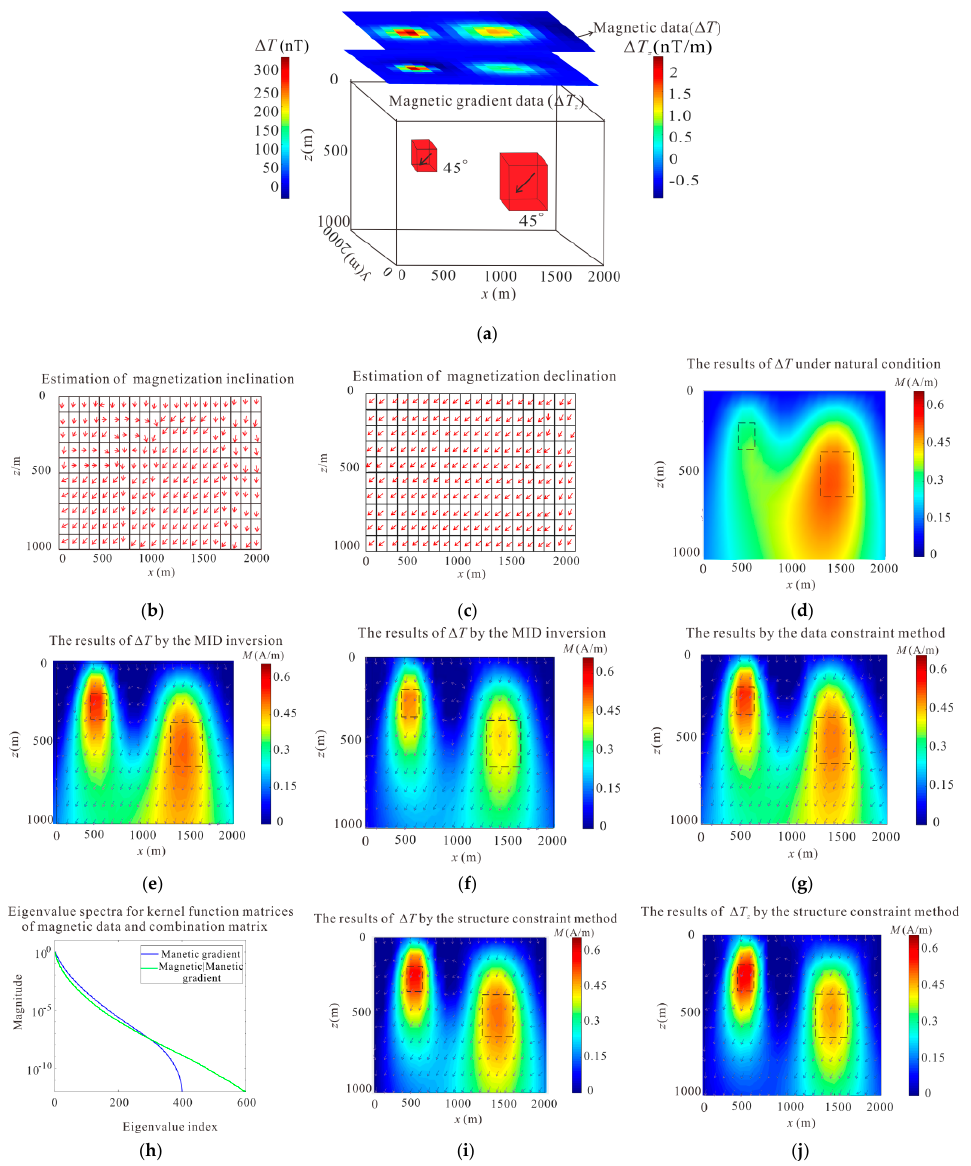
Figure 1. Models with different depths obtained by MID inversion method. ( a ) The synthetic magnetic field and gradient anomaly, and the true magnetization direction is shown with black arrows; ( b , c ) the estimated magnetization inclination and declination by correlation coefficients of the RTP field for the total field; ( d ) the results of synthetic magnetic data under natural conditions by Tikhonov regularization method; ( e , f ) the results of synthetic magnetic data and its gradient data by the MID inversion method, with slices corresponding to y = 1000 m, and the recovered magnetization directions shown with blue arrows; ( g ) the MID inversion results of CMG data, with slices corresponding to y = 1000 m; ( h ) the eigenvalue spectra for kernel function matrices of synthetic magnetic gradient data and the combination data of synthetic magnetic and gradient data; and ( i , j ) the results of synthetic magnetic and magnetic gradient data by the structural constraint inversion method, with slices corresponding to y = 1000 m.